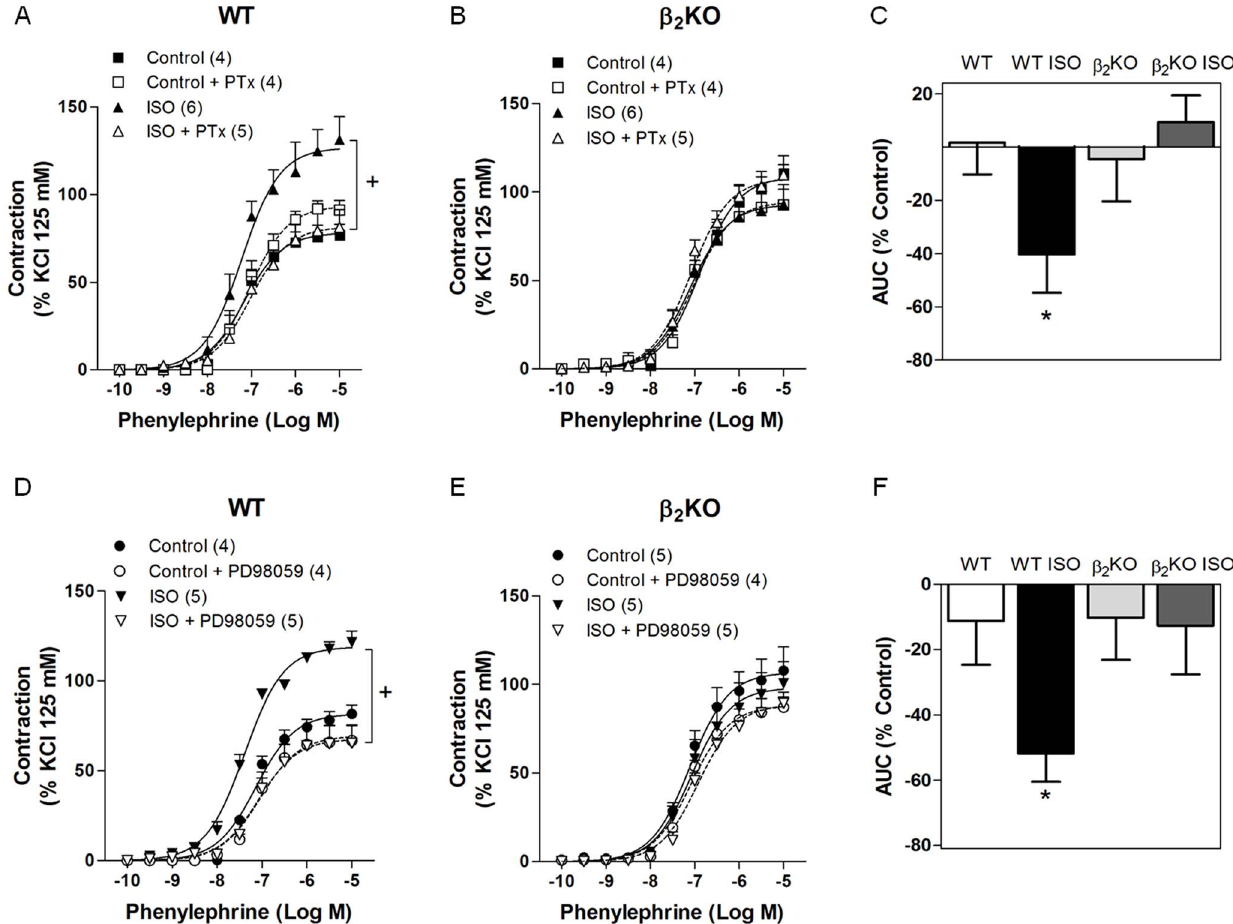
Figure 5. Inhibition of Gi a protein or ERK1/2 activation reversed hypercontractility to phenylephrine induced by b -AR overactivation in aorta of wild-type, but not in b 2 KO mice. Effect of pertussis toxin (PTx, 4 m M) and PD98,059 (1 m M) on the concentration-response curves to phenylephrine in aortic rings of wild-type (WT) (A, D) and b 2 KO (B, E) mice treated for 7 days with vehicle or isoproterenol (ISO). The contraction response is expressed as a % of the contraction to KCl (125 mM). Bar graphs show differences in the area under the concentration-response curve (AUC) in the presence or absence of PTx (C) or PD98,059 (F) in WT and b 2 KO mice treated or not with ISO. Values are presented as the mean 6 SEM. The number of animals used in each group is indicated in parenthesis. Significance was assessed using a 2-way ANOVA: + p , 0.05 vs. WT ISO; *p , 0.05 vs. WT.